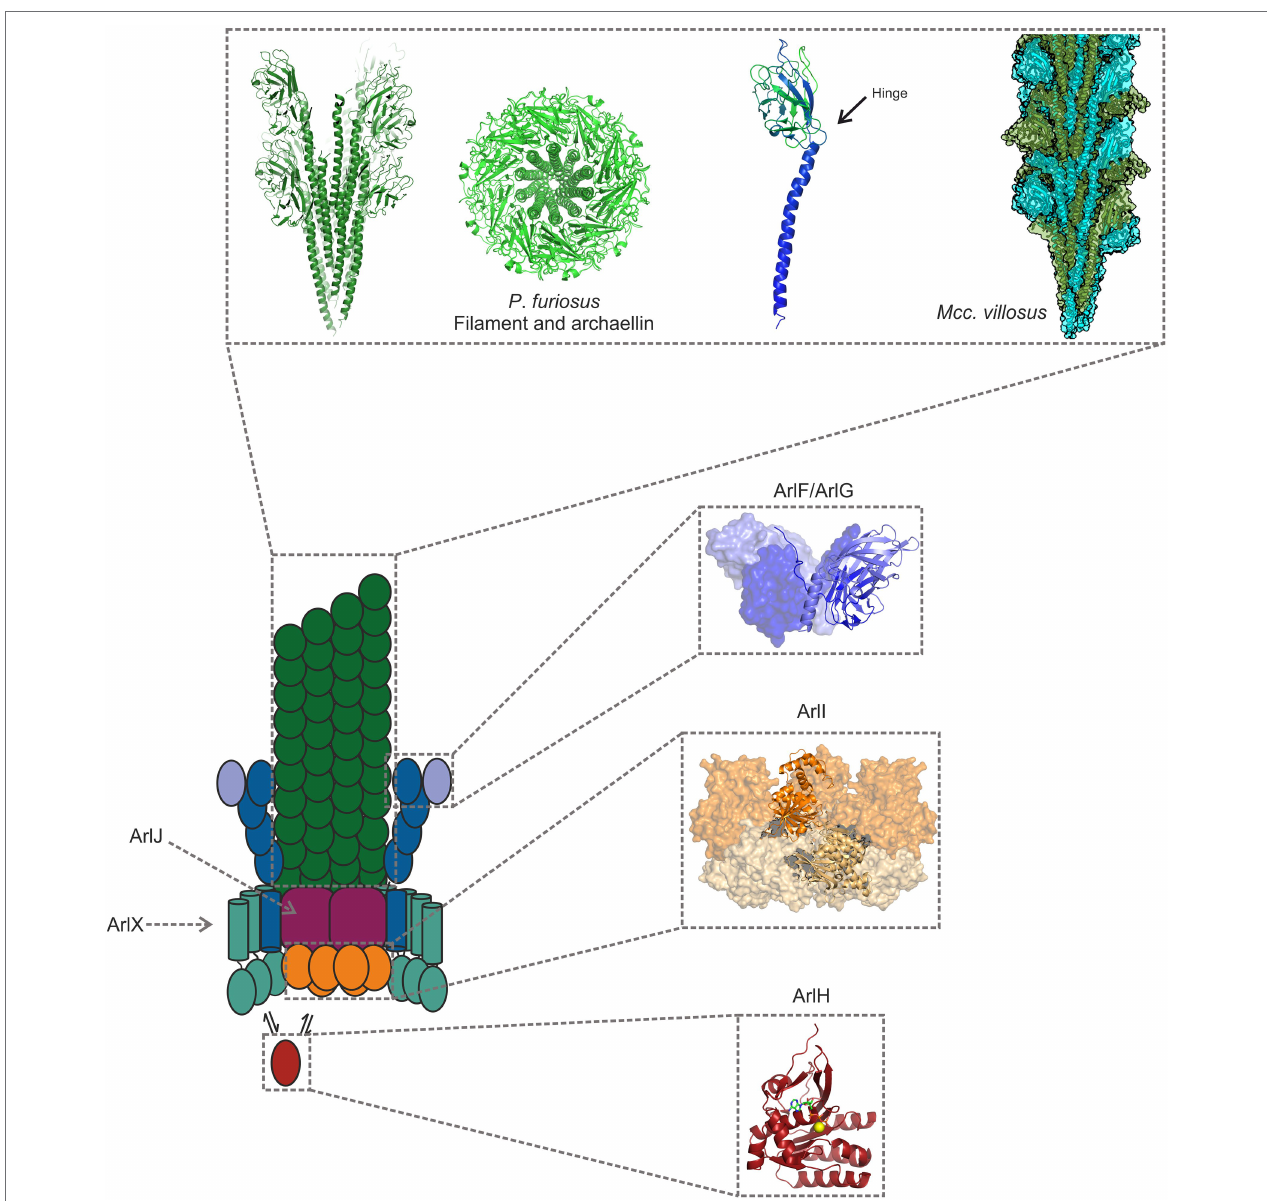
FIGURE 2 | Model of the archaellum machinery. The filament consists of tadpole shaped archaellins (left), with an N-terminal α -helical tail and a β -sheet rich, globular head domain. The hydrophobic tails make up the core of the archaellum, while the hydrophilic heads face the filament’s exterior (Poweleit et al., 2016; Daum et al., 2017; Meshcheryakov et al., 2019; Gambelli et al., 2021). Two filaments are shown in the figure: one from Pyrococcus furiosus , and another from Methanocaldococcus villosus (PDB-7OFQ), a heteropolymeric filament. ArlG forms a filament that spans the pseudoperiplasm and that is tightly anchored to the S-layer by a heterotetramer consisting of ArlG and ArlF (Banerjee et al., 2015; Tsai et al., 2020; Umrekar et al., 2021). ArlI is the hexameric ATPase, which localises to the cytosolic side of the plasma membrane, probably owing to its interaction with the platform protein ArlJ, whose structure has not yet been determined (Reindl et al., 2013). ArlH is an auto-kinase that interacts with ArlI, modulating its activity and perhaps controlling when the ATPase assembles or rotates the filament (Chaudhury et al., 2016; Sousa Machado et al., 2021). The filament structure has been obtained from P. furiosus (5O4U; Daum et al., 2017), and the remaining structures from Sulfolobus acidocaldarius proteins 5TUG (Tsai et al., 2020); 4IHQ (Reindl et al., 2013); and 4YDS (Chaudhury et al.,